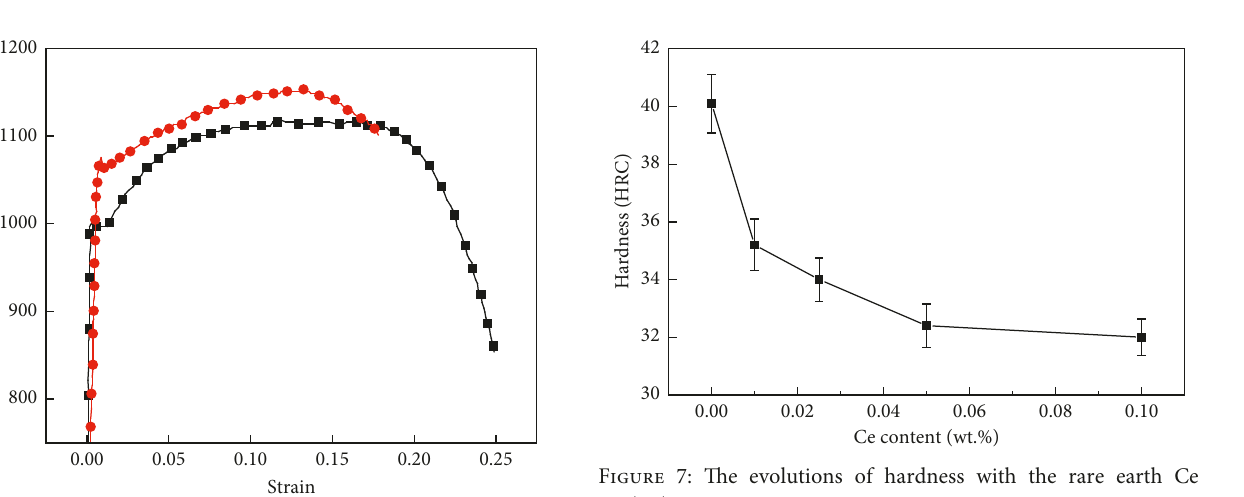
Figure 5: The evolutions of strengths and elongations with the rare earth Ce content: (a) tensile strength and yield strength; (b) elongation after breakage.